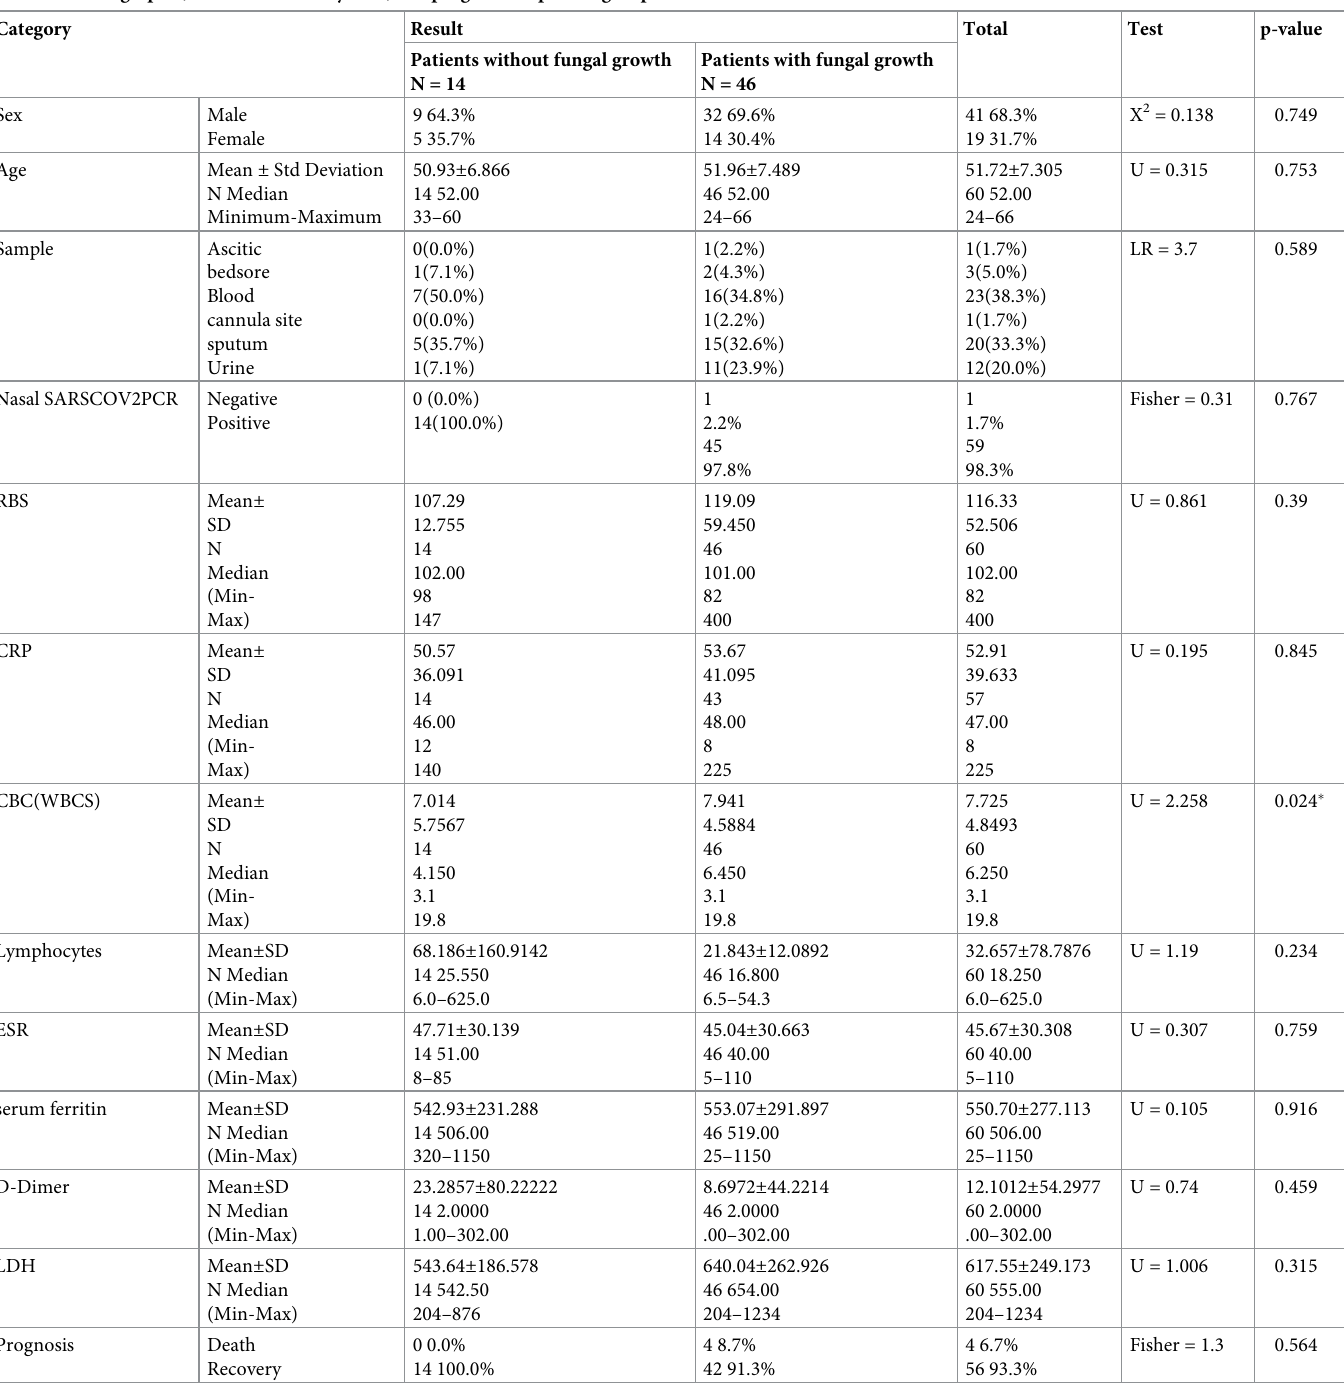
Table 2. Demographic, clinical-laboratory data, and prognosis of patient groups.